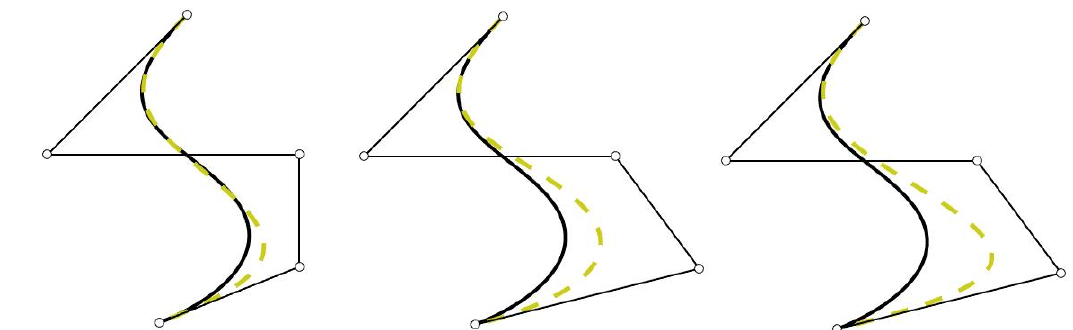
Figure 1. Initial curve (line) and curve obtained (dotted line) after changing the weights and/or control points. Left: changing the fourth weight; center: changing the fourth control point; and right: changing the fourth weight and the fourth control